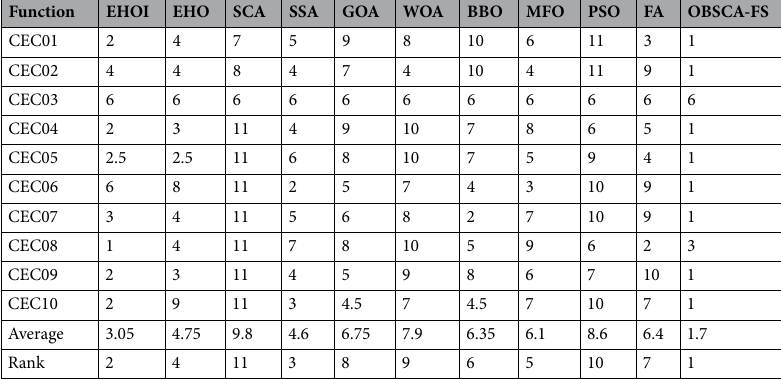
Table 3. Friedman ranks for the comparable method over 10 CEC2019 instances.